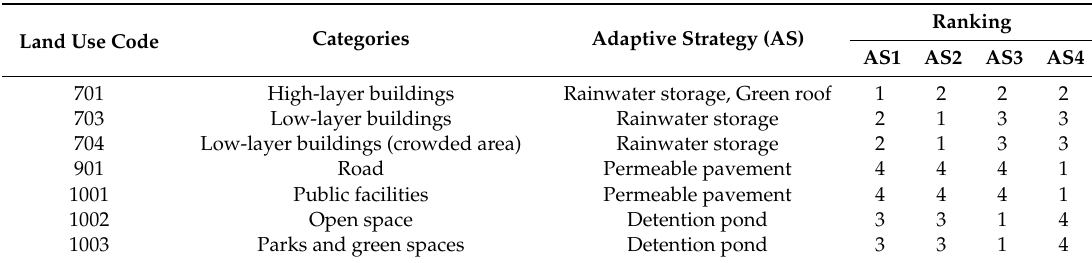
Table 6. Ranking of four di ff erent climate adaptation strategies corresponding to the categories of land use in a section of a ward.